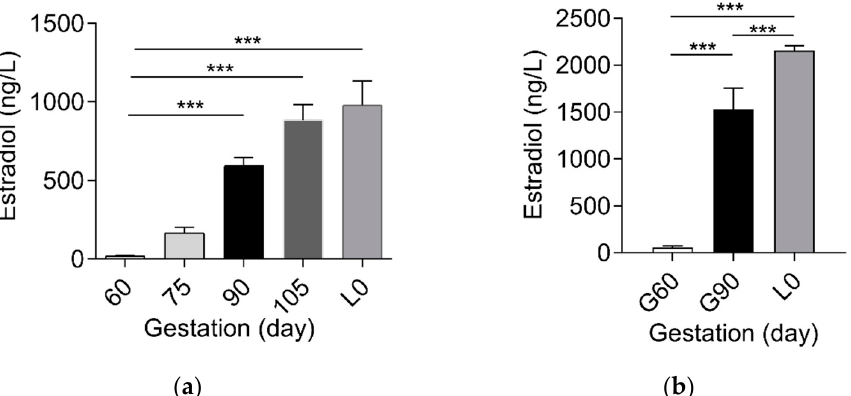
Figure 1. ( a ) Comparison of maternal serum estradiol at G60, day 75 of gestation (G75), G90, day 105 of gestation (G105), and L0, ( b ) and fetal serum estradiol at G60, G90, and L0 (n = 6–7/group). Data are shown as means ± SE, *** p < 0.001.